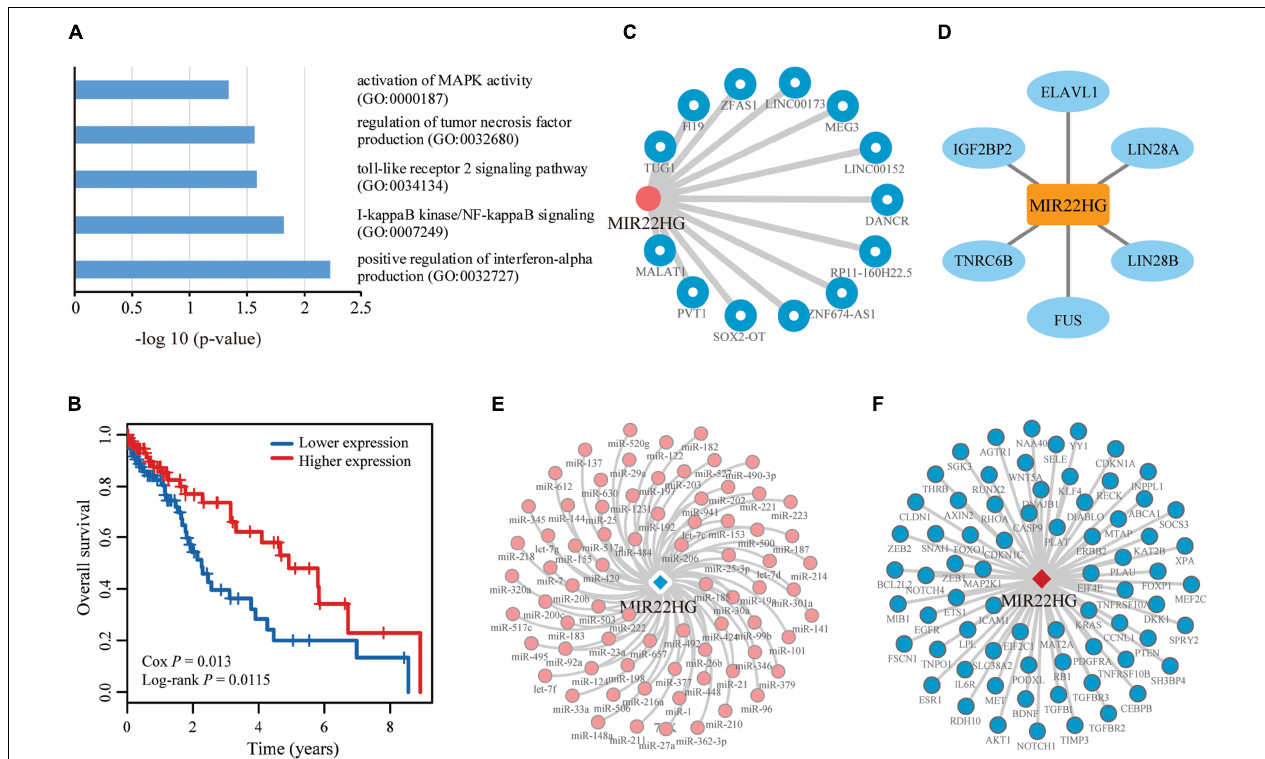
FIGURE 6 | Function and network analyses of the top prioritized lncRNA in LIHC. (A) LIHC-related GO biological processes enriched for the top 20 lncRNAs identified using CLING. (B) Kaplan–Meier curves of two patient groups with higher (top 50%; n = 100) or lower (bottom 50%; n = 100) expression of MIR22HG in LIHC. Survival days are shown along the X axis and Overall survival rates along the Y axis. (C–F) Subgraphs formed by lncRNA MIR22HG and its directed neighbors associated with LIHC in LCE, lncRNA ceRNA network; LPI, lncRNA–protein interaction network; LMI, lncRNA–miRNA interaction network, and LMCE, lncRNA–mRNA ceRNA network,